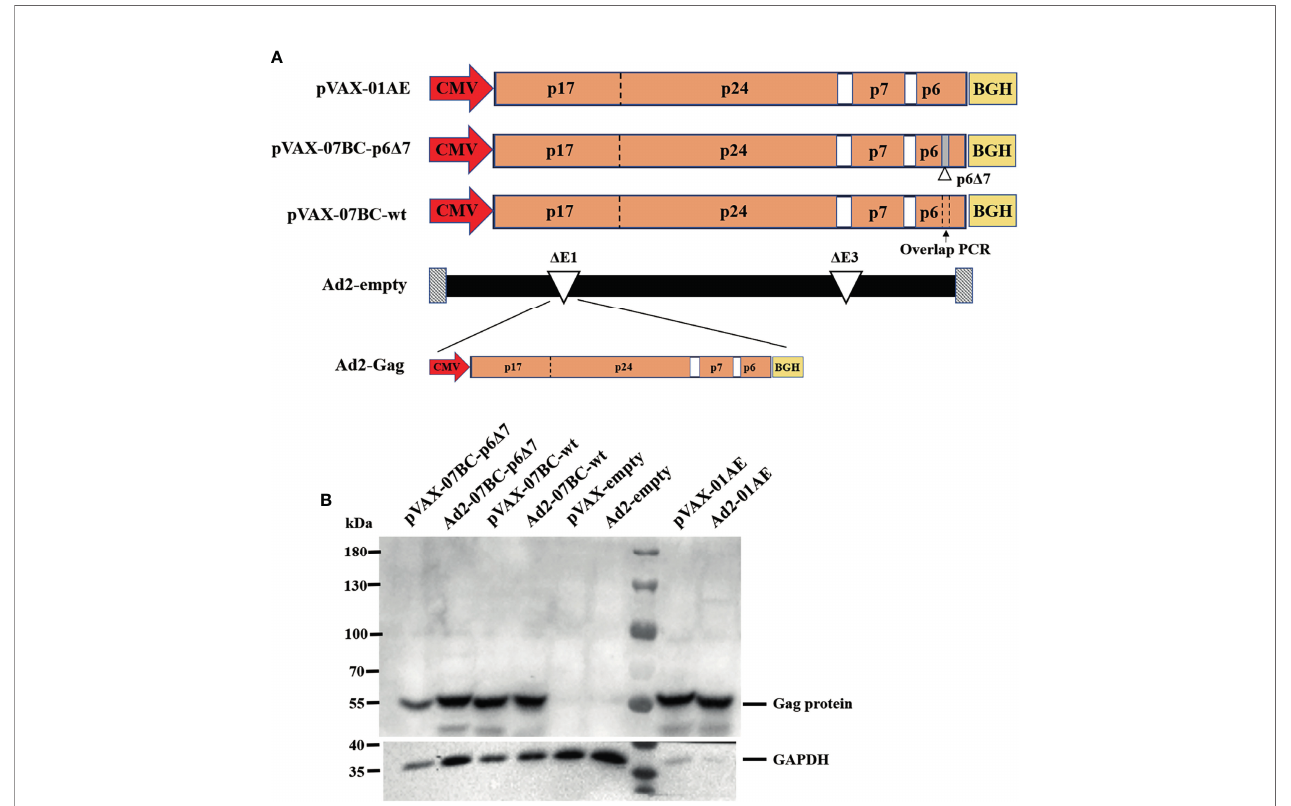
FIGURE 1 | Construction and characteristic of the DNA vectors and Ad2-based vectors carrying the Gag protein of different HIV-1 subtypes. (A) Diagrammatic sketch of constructing pVAX-1 and Ad2 vectors carrying various Gag genes under CMV promoter and the gene structure of Gag. There are seven amino acid deletions in Gag protein encoded by 07BC-p6 D 7, while the deletions were supplemented in 07BC-wt through overlap PCR. (B) Western blotting analysis of the expression of various Gag proteins in HEK293 cells in 6-well plates transfected with plasmids encoding a codon-modi fi ed Gag sequence (pVAX-01AE, pVAX-07BC- p6 D 7, or pVAX-07BC-wt, 2 m g per well) or infected with recombinant Ad2 virus (Ad2-01AE, Ad2-07BC-p6 D 7, or Ad2-07BC-wt, 0.2 TCID50 per well). pVAX-empty plasmid and Ad2-empty virus were used as the negative control. The GAPDH blot examined in parallel served as an internal